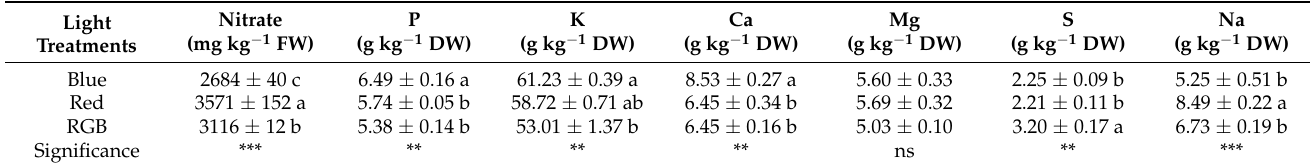
Table 3. Nitrate and macro-minerals of parsley microgreens with reference to the different light treatments (red, blue and RGB).